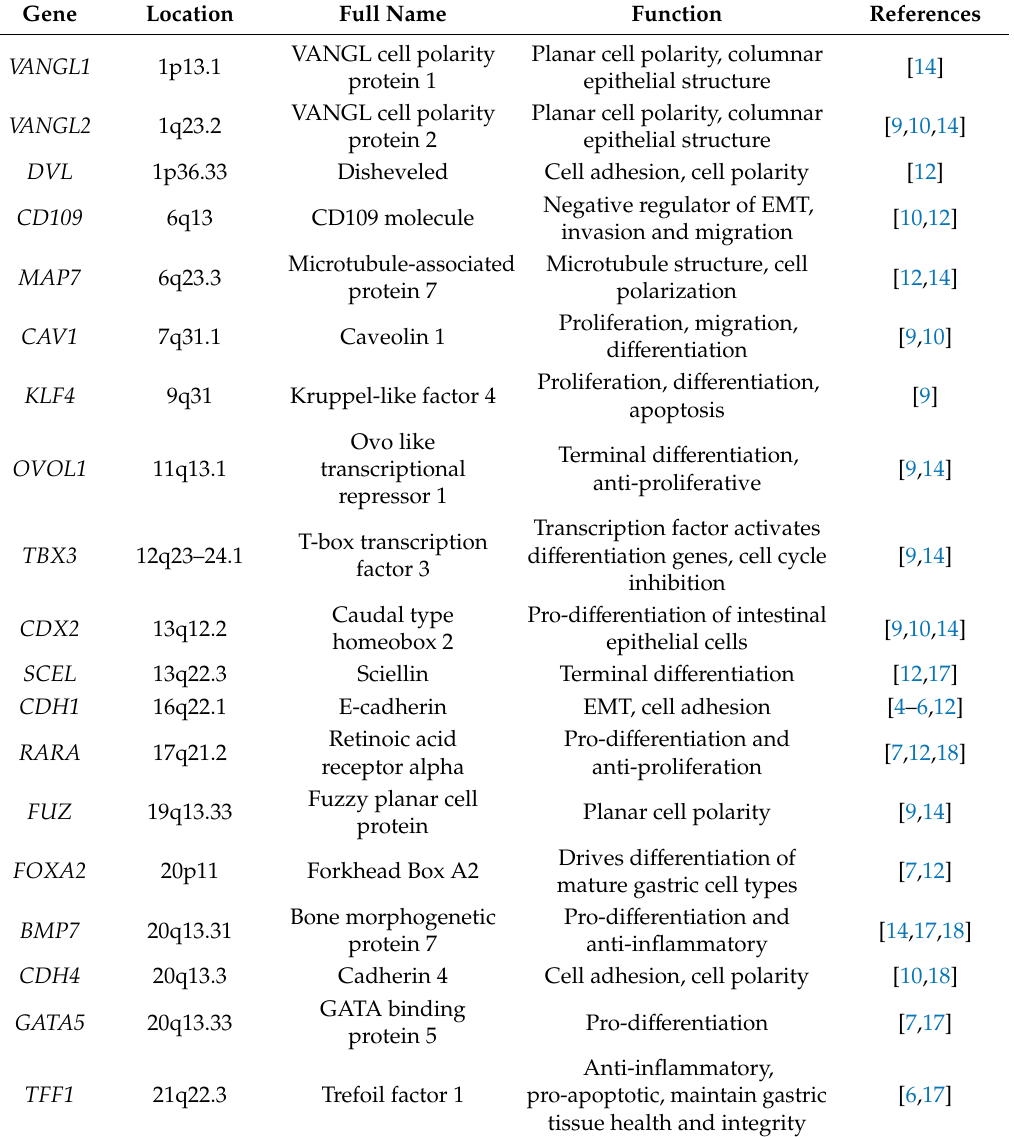
Table 3. Genes involved in cellular di ff erentiation that are often silenced in EBVaGC. Di ff erentiation genes were identified from the gene ontology term epithelial cell di ff erentiation pathway (GO:0030855). Lists of silenced and down-regulated genes from available data sets were cross-referenced and selected genes were present in multiple datasets as noted in the references